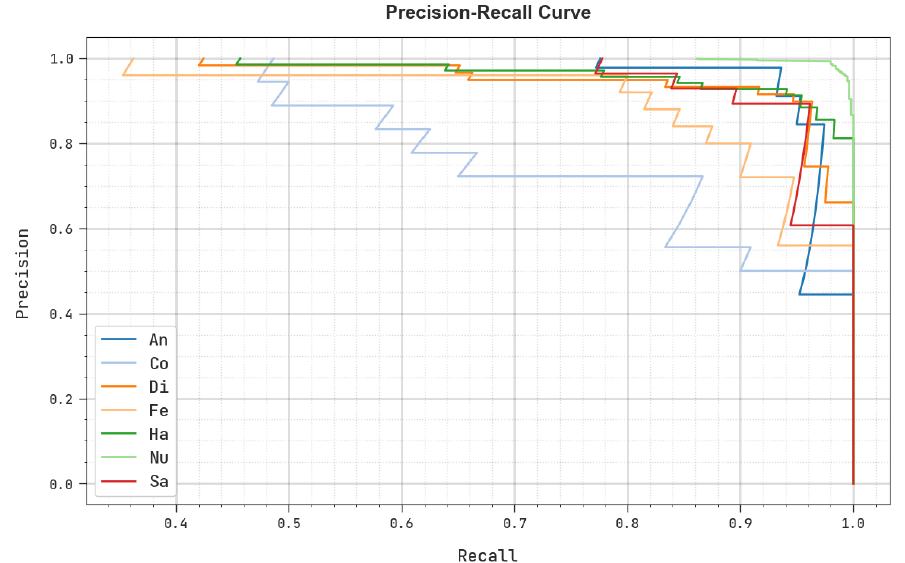
Figure 12. Precision–recall analysis of the RFER-EADL algorithm.